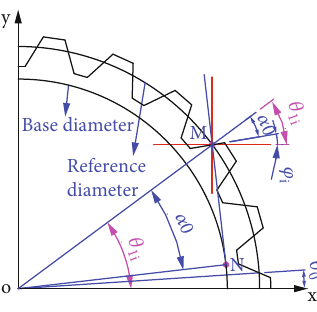
Figure 5: Diagram of the related